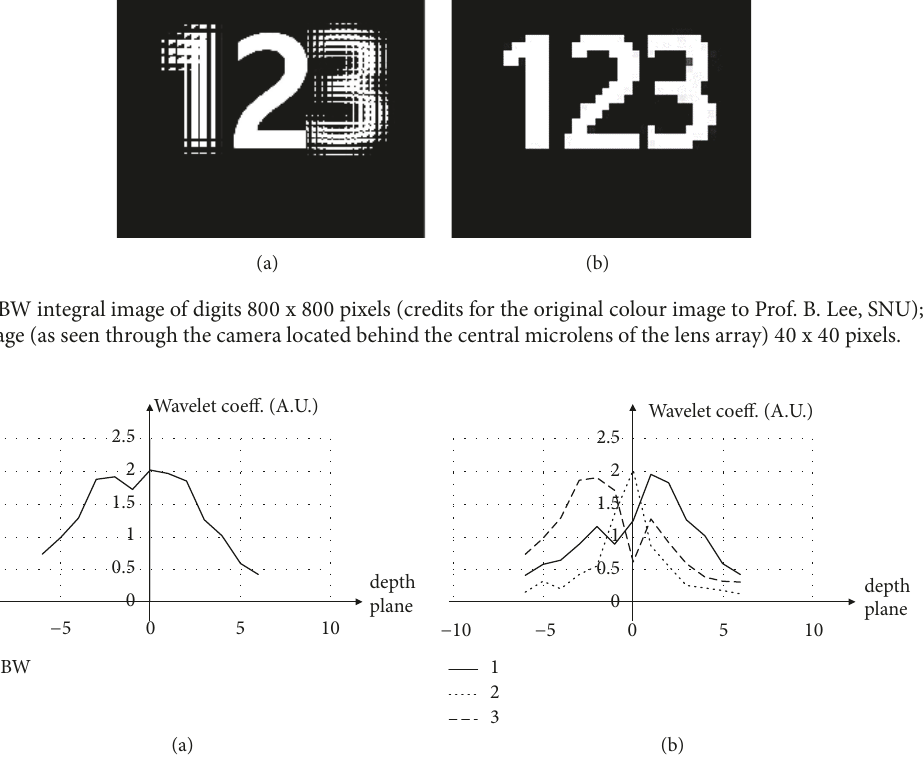
used as a simple graphical picture of all objects of a 3D image, because in the original integral image, the objects may look unclear (nonsharp, or out-of-focus, or blurred, etc.); compare Figures 1(a) and